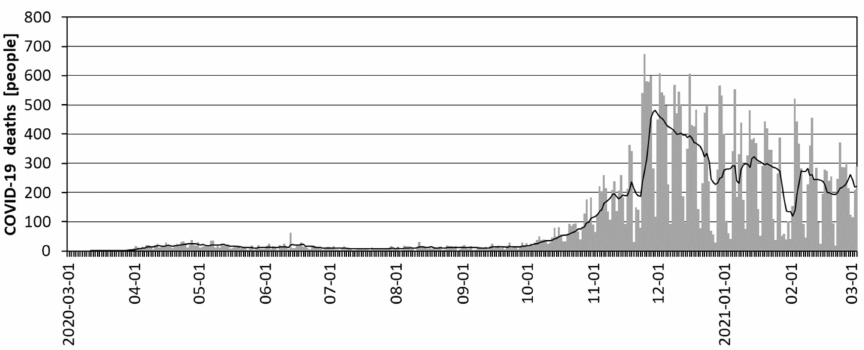
Figure 5. Daily COVID-19 deaths in Poland, including the 7-day average, in March 2020–March 2021 (Source: